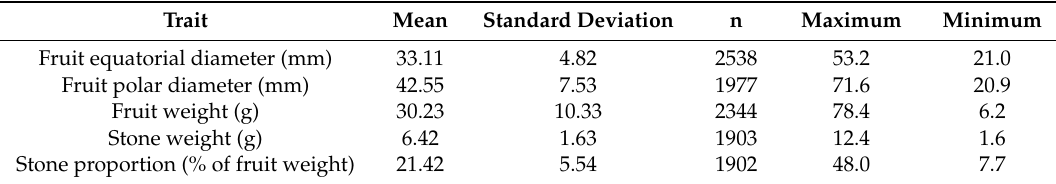
Table 1. Measurements of Gomortega keule